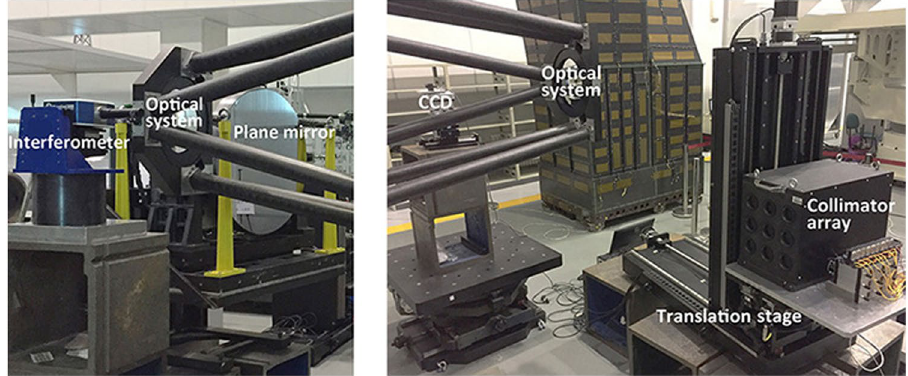
Figure 8. Layout of the auto-collimating test (left) and MASTS (right).